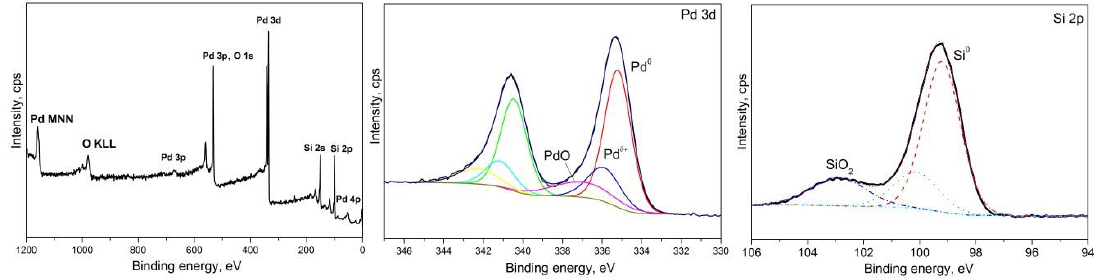
Figure 6. X-ray photoelectron spectroscopy (XPS) spectra of a Pd nanoparticles on a Si(100) substrate after etching with Ar+ ions.